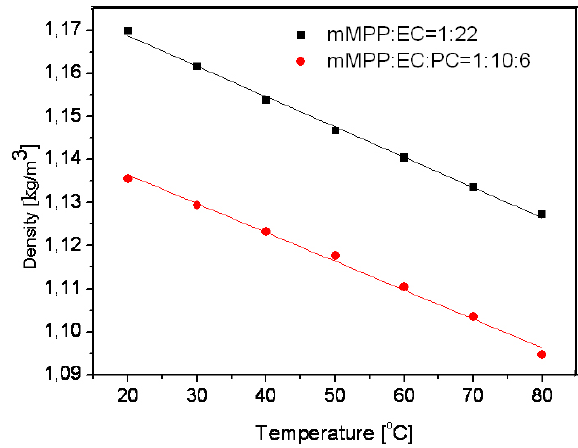
Fig. 5. Dependence of density in function of temperature for the oligoetherols obtained in molar ratio as shown in insert.